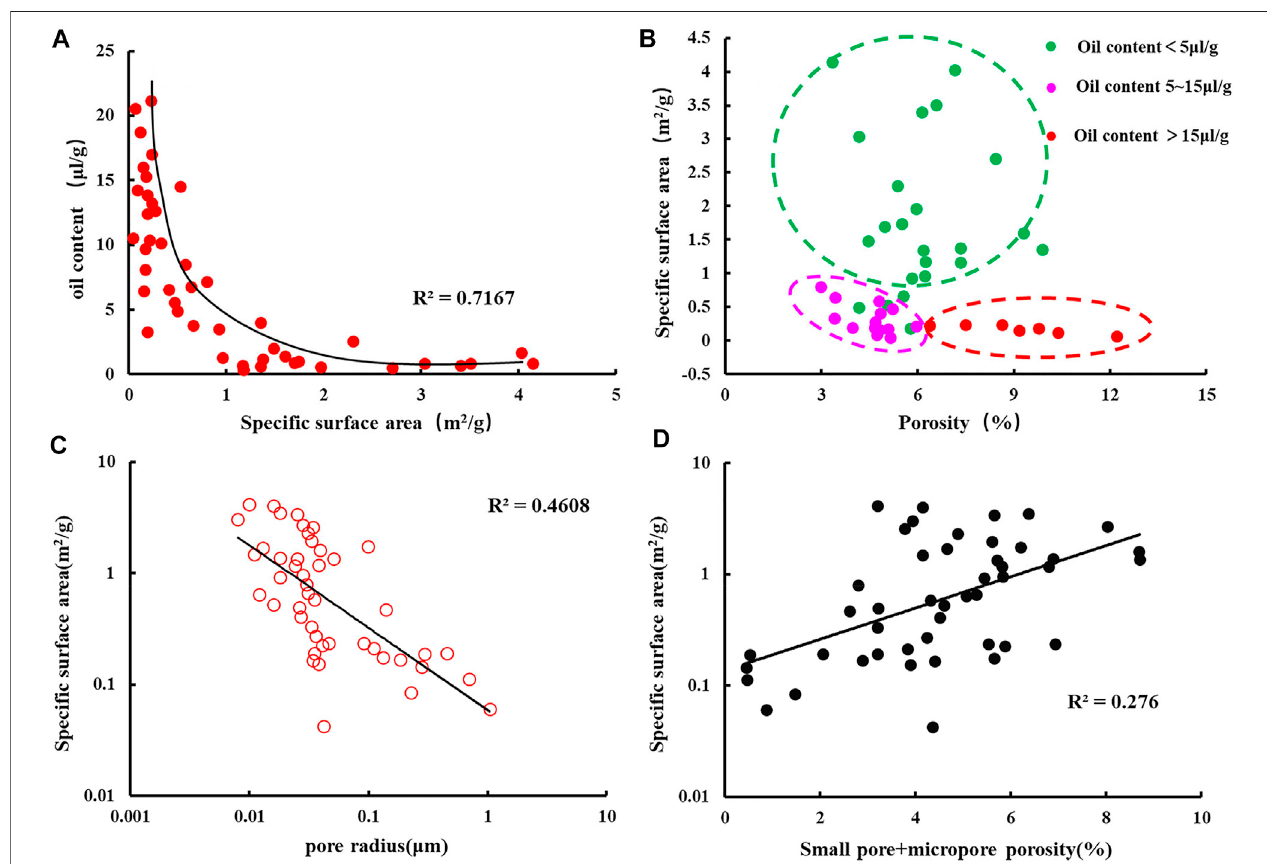
FIGURE 14 | (A) The relationship between speci fi c surface area and oil content; (B) The relationship between porosity and speci fi c surface area; (C) The relationship between pore radius and speci fi c surface area; and (D) The relationship between samll pore + micropore porosity and speci fi c surface area.